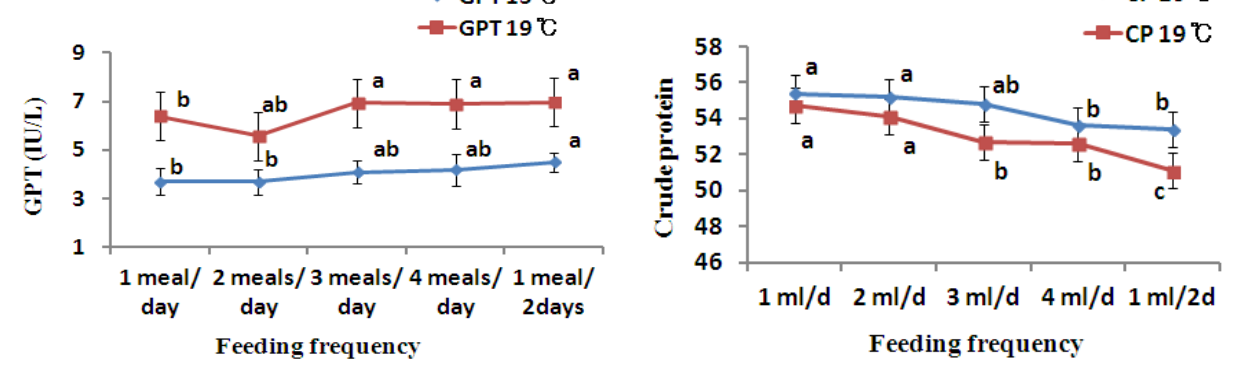
Figure 5. Whole body crude protein of rockfish with different feeding frequencies at 15°C and 19°C.